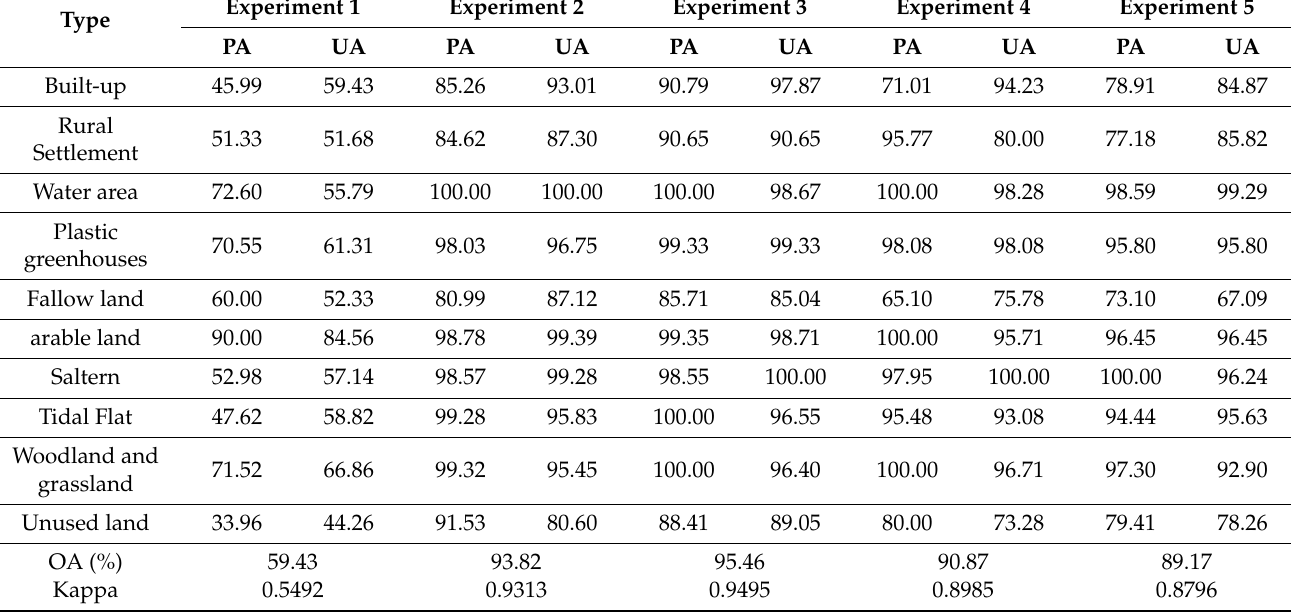
Table 4. Accuracy comparison with different